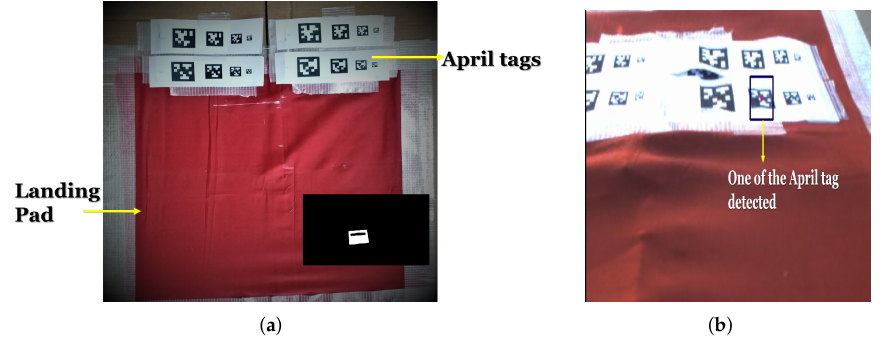
Figure 2. ( a ) Target setup for autonomous landing. Inset figure shows extracted contour of red blob ( b ) One of detected